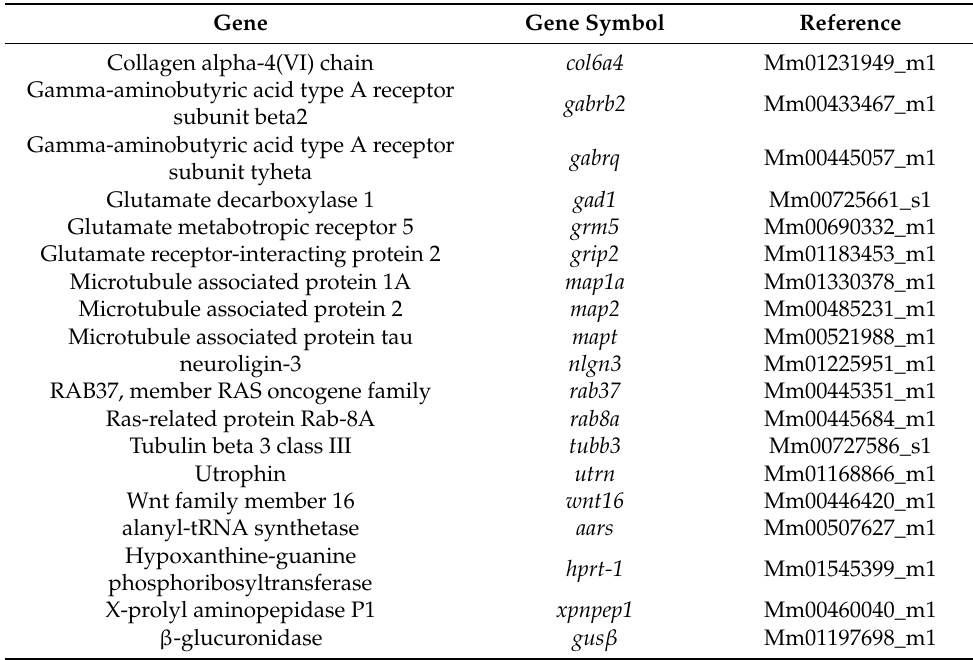
Table 1. List of TaqMan probes used to assess transcript levels by RT-qPCR. Gene Gene